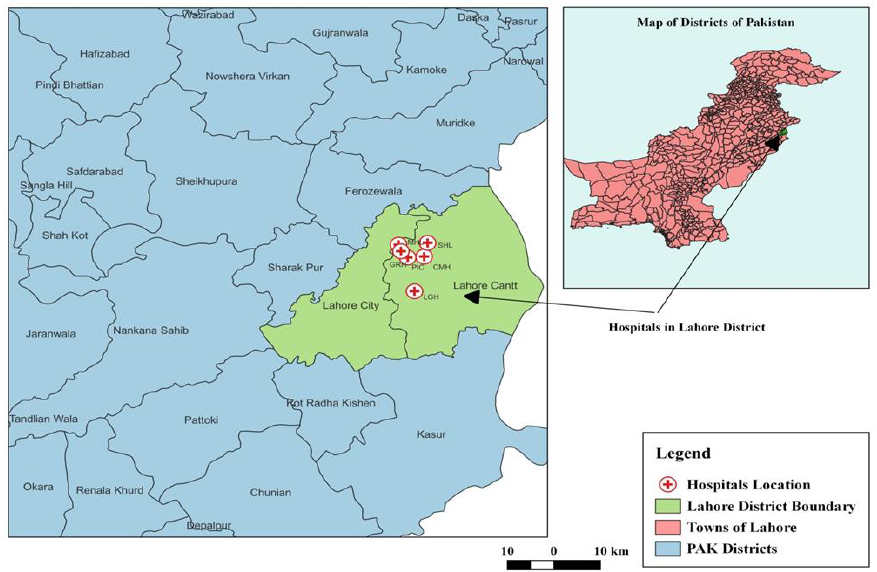
Figure 1. Study map area of the hospitals ’ location in Lahore District .